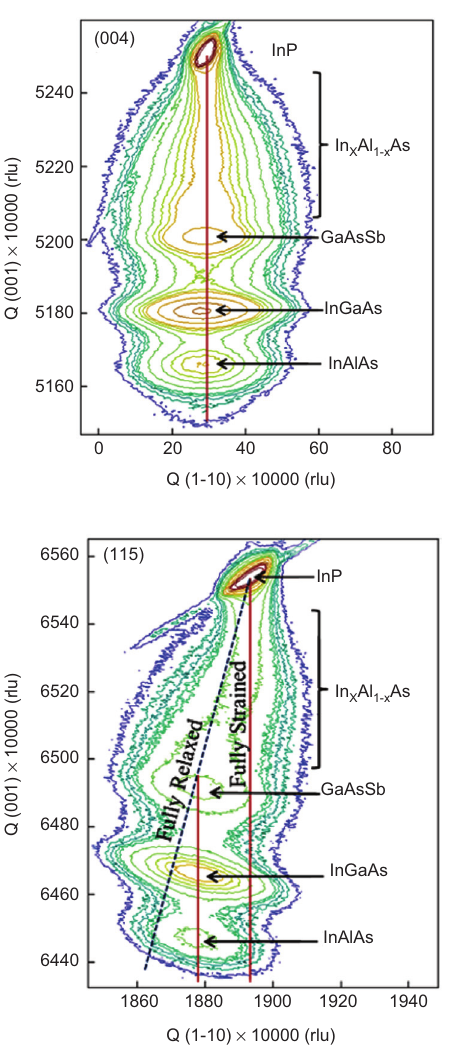
Figure 18 (A) Symmetric (004) and (B) asymmetric (115) RSMs of the InAs-like interface TFET with a layer structure as shown in Figure 17C using an incident X-ray beam along the [1ī0] direction. Reprinted from Ref. [11], with permission, from the American Institute of Physics, copyright (2012), AIP Publishing